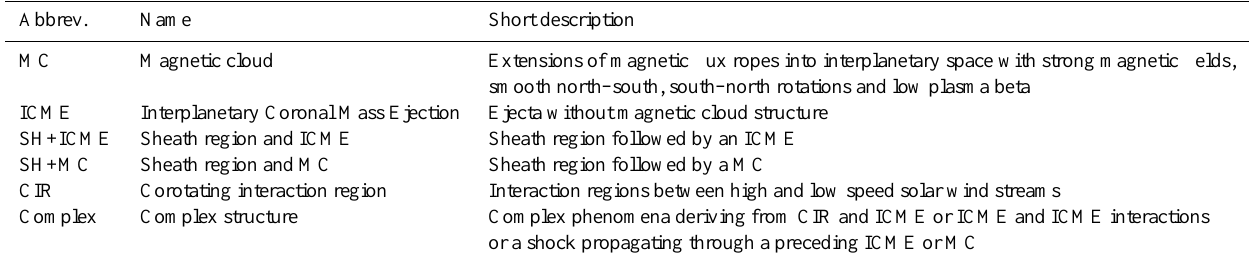
Table 1. Interplanetary phenomena causing strong geomagnetic storms. The table has been made according to the phenomena described in Zhang et al. (2007). Abbrev.